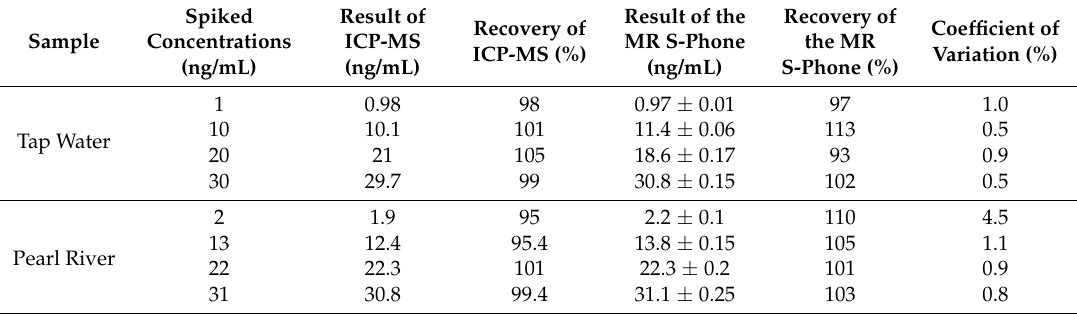
Table 1. Detection of Hg 2+ in tap water samples and Pearl River samples (Guangzhou, China) using the MR S-phone system.